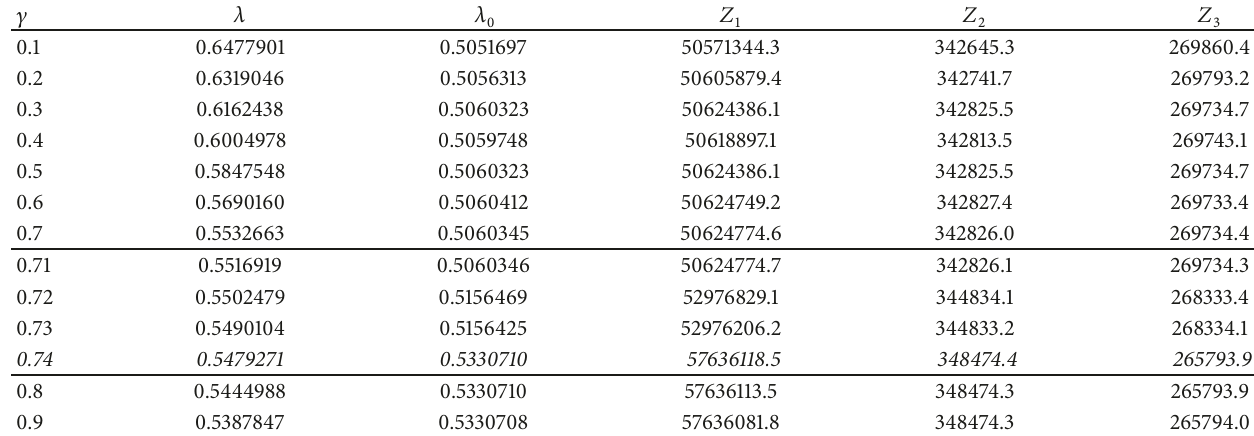
Table 14: Impacts of different compensation coefficient ( 𝛿 = 0.02